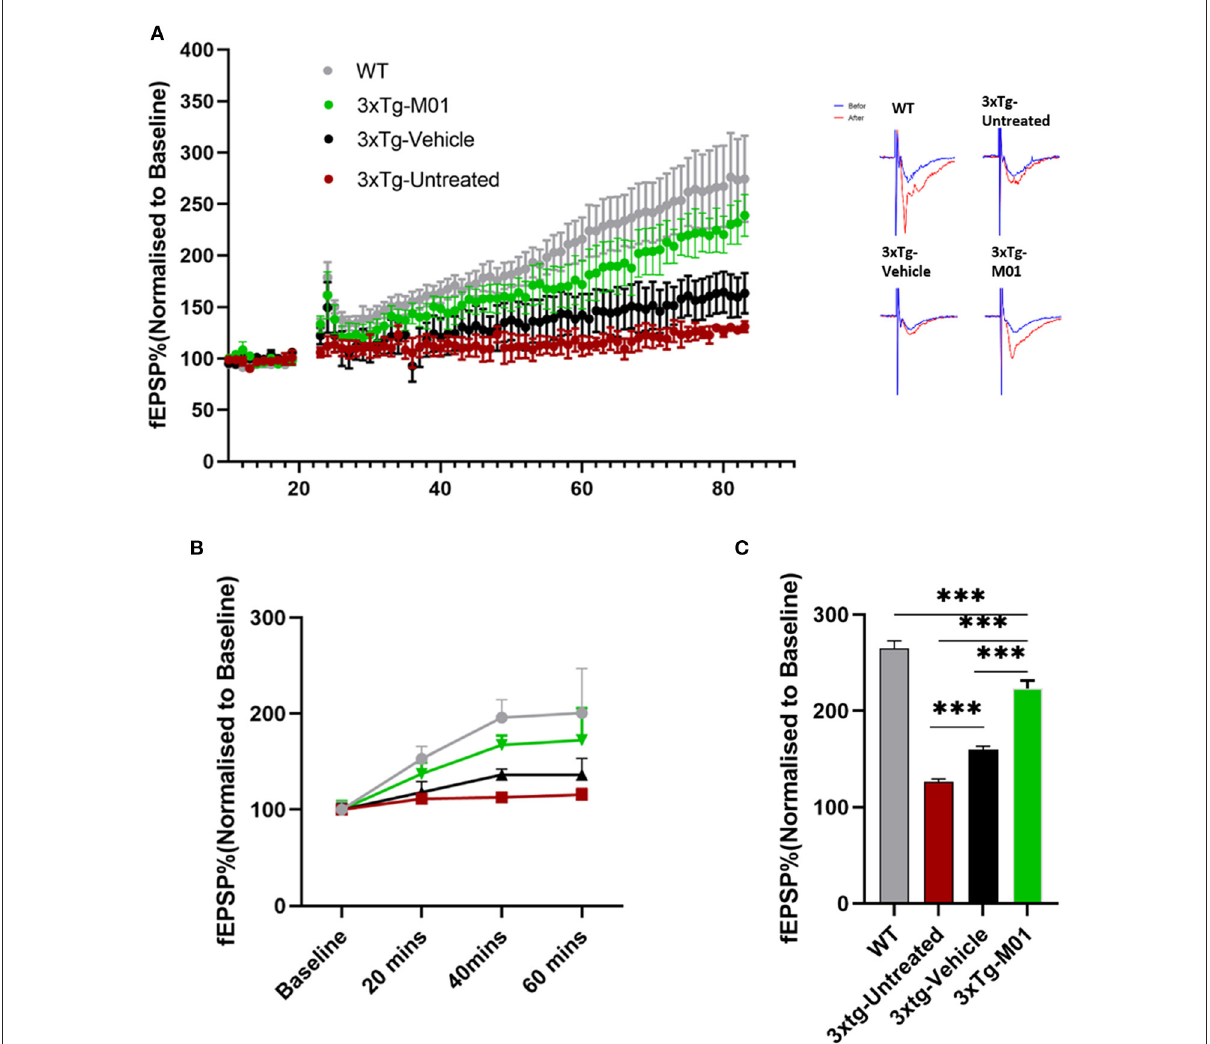
FIGURE6 Enhanced CA1 long-term potentiation was recorded in M01-administered 3xTg-AD mice. (A) Average values of fEPSPs (normalized to baseline) were plotted for each group along with representative traces of LTP. (B) fEPSP slope plotted by different time points. (C) Quantitative graphs show a significant difference in LTP between WT, 3xTg-untreated, 3xTg-vehicle, and 3xTg-M01. *** p ≤ 0.000. n = 3–4/group. The results are plotted as the mean ± SEM, and one-way ANOVA followed by Tukey’s post hoc test was applied for multiple